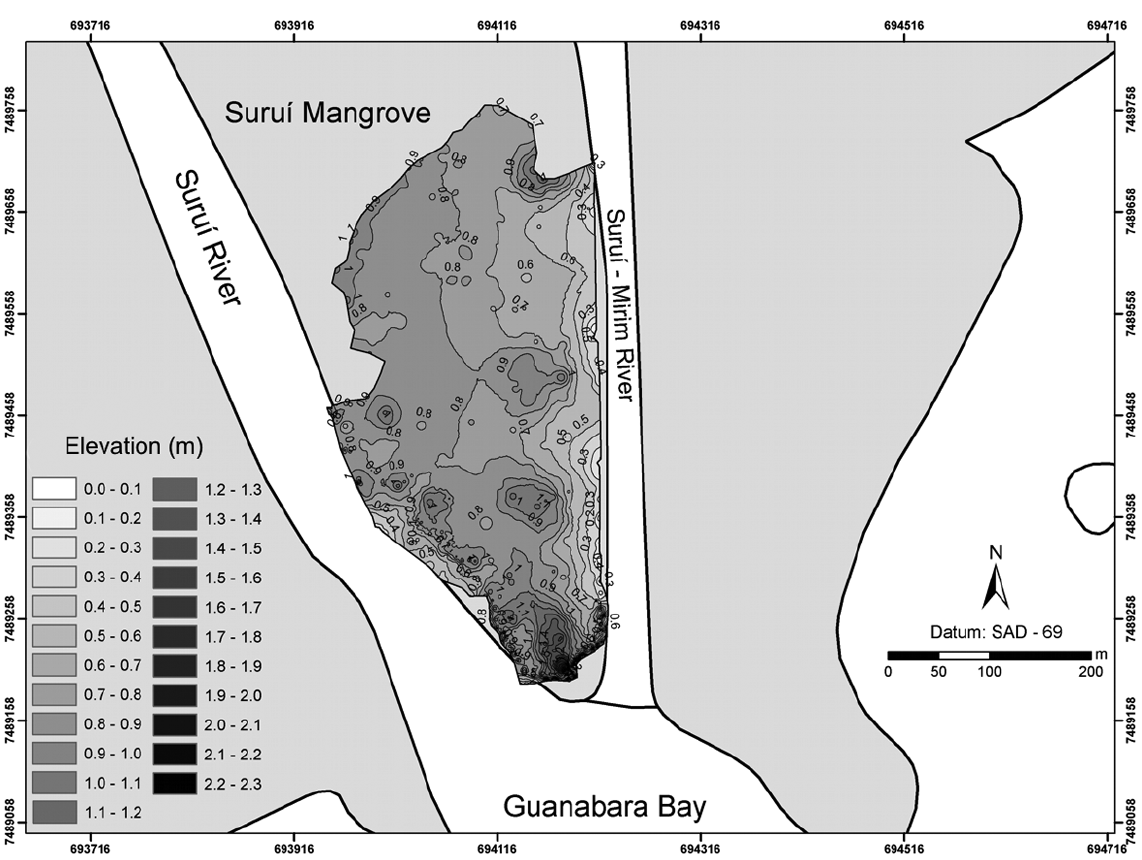
Fig. 2 – Suruí Mangrove